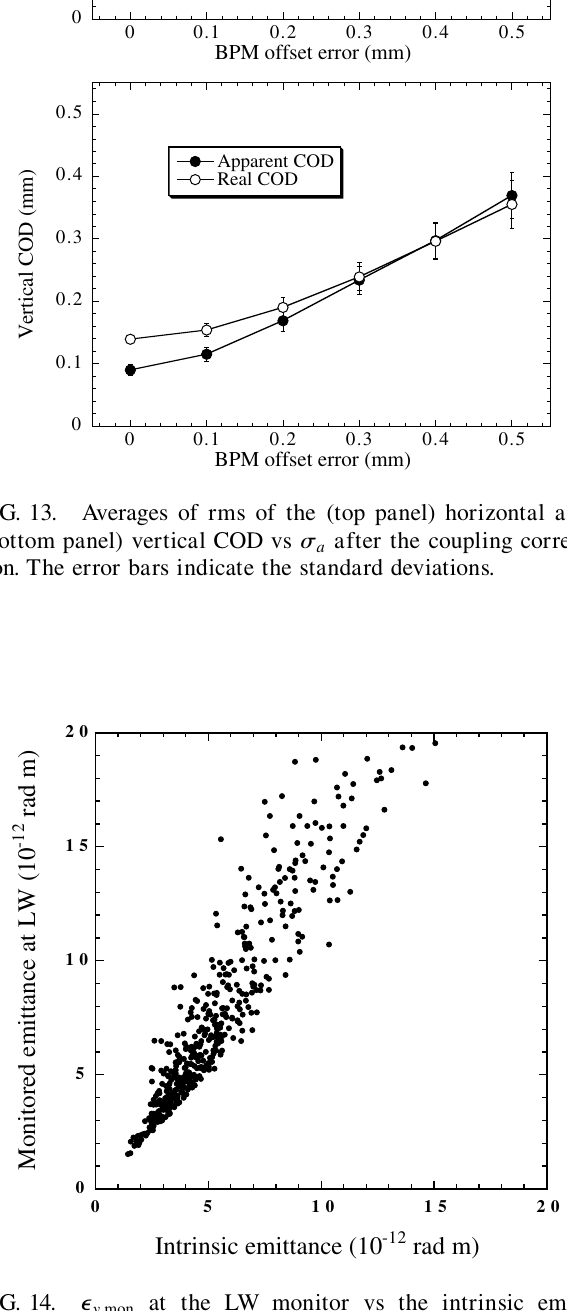
FIG. 14. (cid:26) at the LW monitor vs the intrinsic emit- y; mon . tance, (cid:26) y